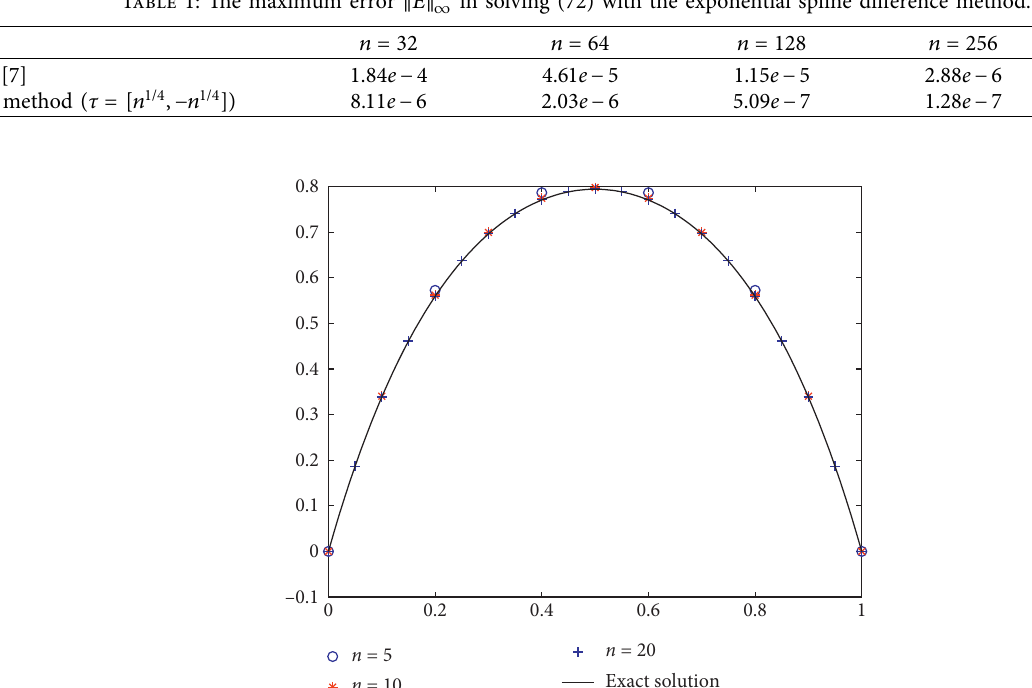
Table 1: The maximum error ‖ E ‖